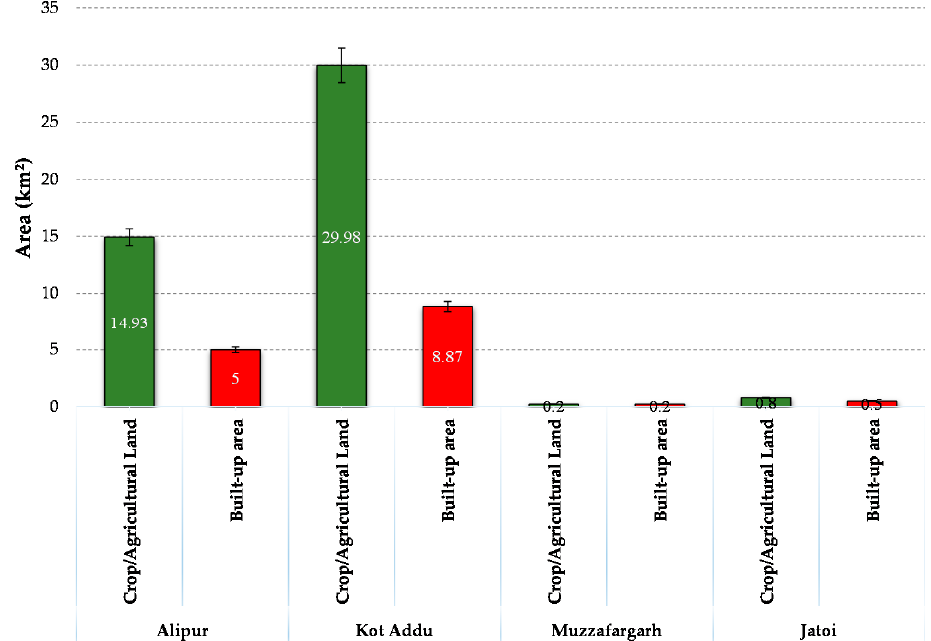
Figure 5. Damage assessment to the ‘crop/agricultural land’ and ‘built-up areas’ LULC categories for each subdivision of the district following the 2014 flood.